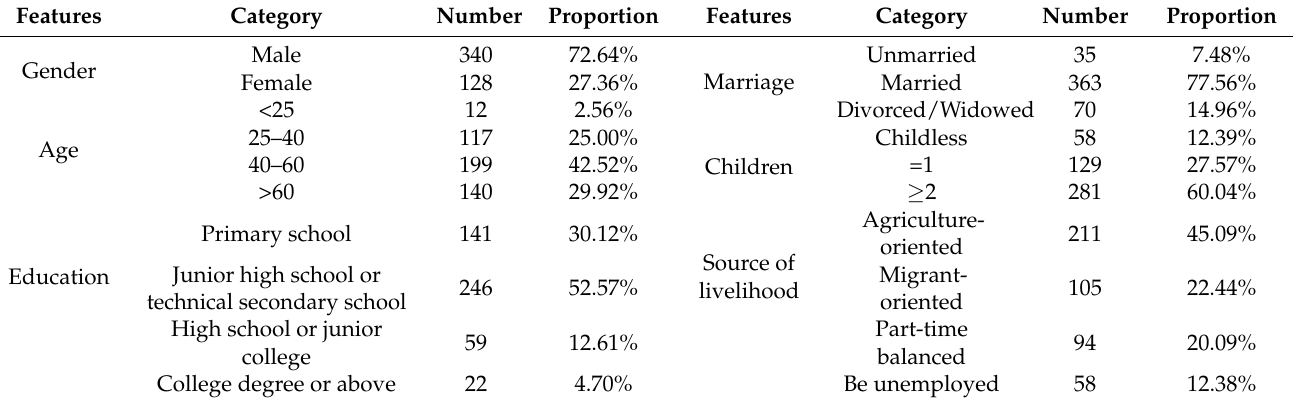
Table 3. Basic characteristics of the survey sample